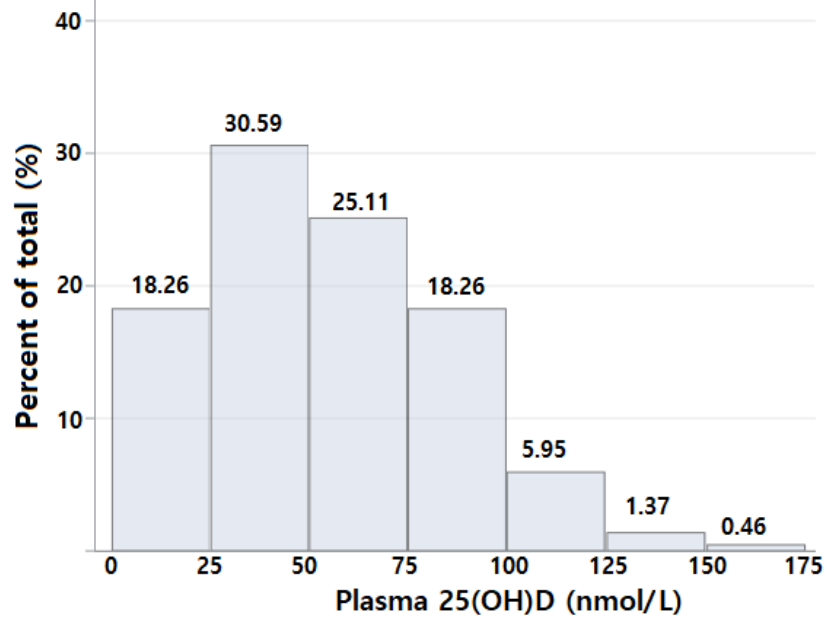
Figure 1. Measured plasma 25(OH)D (nmol/L) among breast cancer survivors in Korea. Table 1. Characteristics of study participants according to plasma 25(OH)D concentrations.